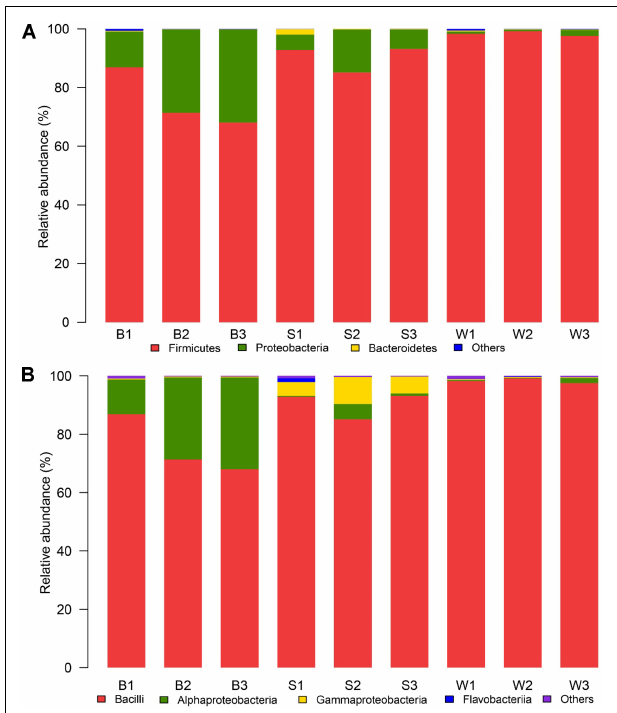
FIGURE 3 | Relative abundance of the bacterial phyla (A) and classes (B) recovered from three types of starters by high-throughput Illumina sequencing. The phylum or class with relative abundance greater than 1% of the total sequences were displayed, the relative abundances less than 1% of the total sequences was defined as